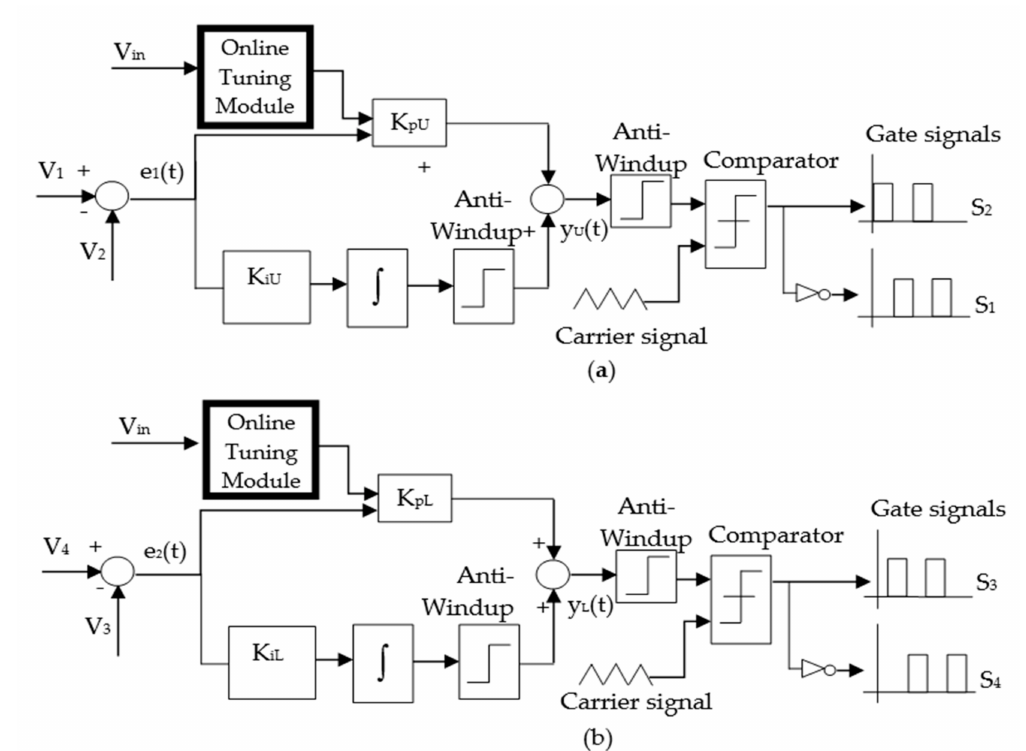
Figure 5. Block diagram of the proposed PI controllers with online tuning module. ( a ) Upper part of buck-boost converter. ( b ) Lower part of buck-boost converter.